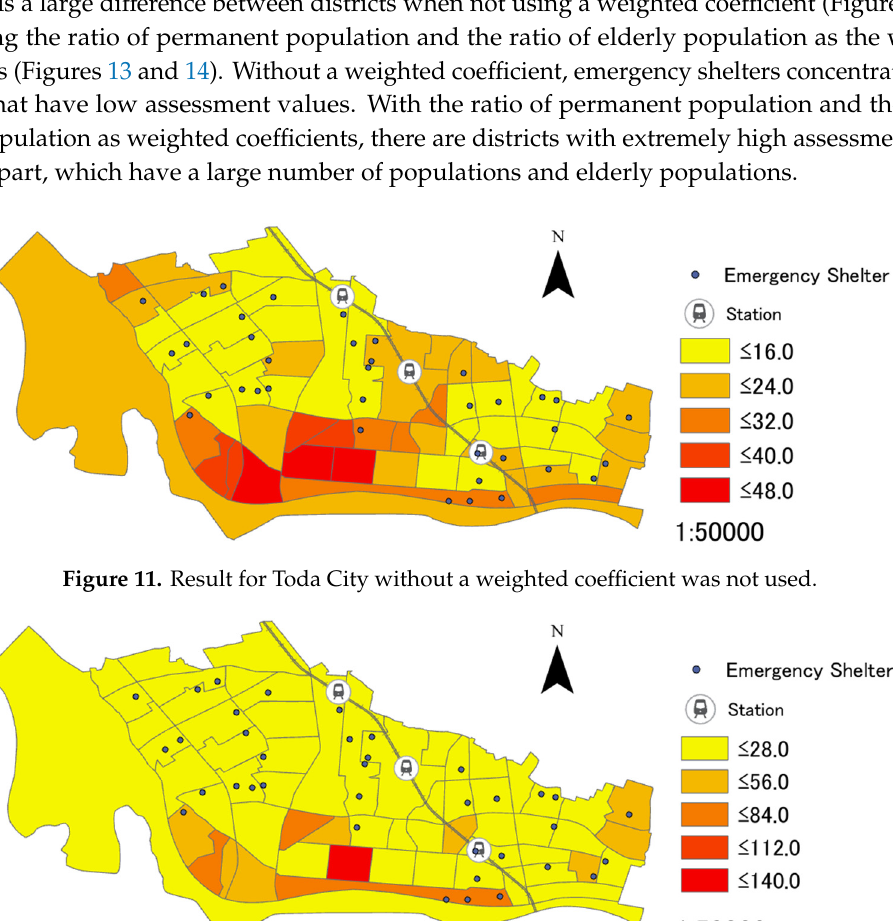
Figure 12. Result for Toda City with the specialization coe ffi cient of elderly population as a